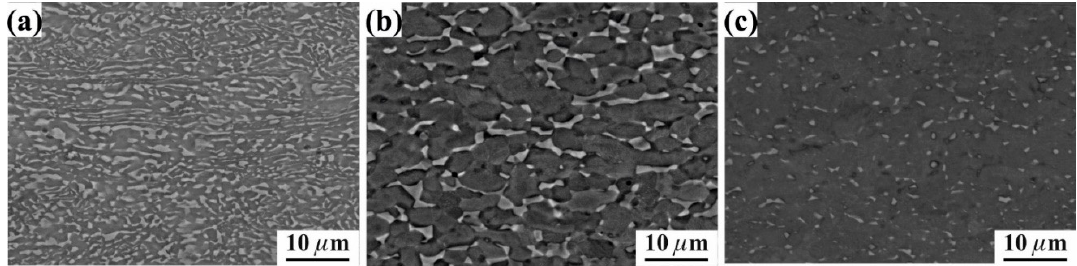
Figure 2. Initial microstructure of the investigated alloys: Ti-3%Mo-1%V-4%Al alloy ( a ); Ti-4%V-6%Al alloy ( b ); and Ti-1.8%Mn-2.5%Al alloy ( c ).